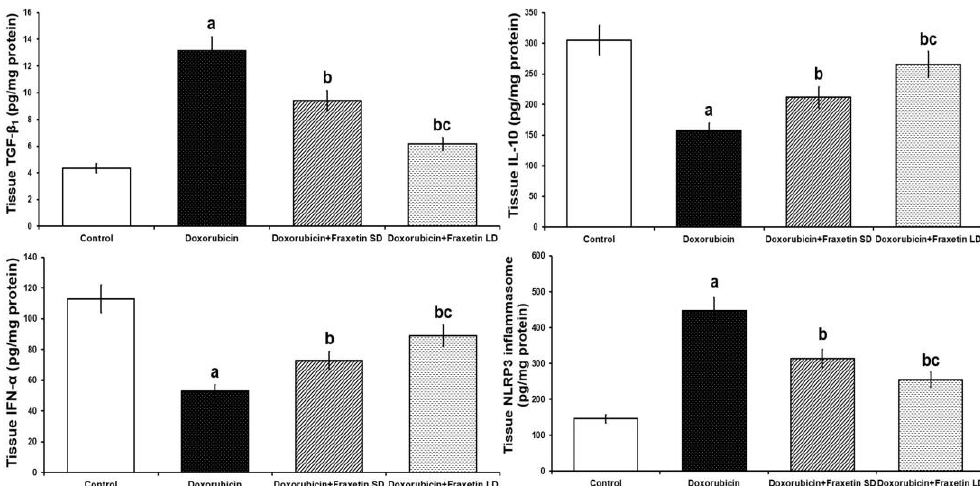
Figure 2. Effect of different doses of fraxetin on cardiac tissue TGF-β1, IL-10, IFN-α, and NLRP3 inflammasome in doxorubicin-treated rats (Mean ± SD). a Significant relative to the control group ( p -value less than 0.05); b Significant relative to doxorubicin group ( p -value less than 0.05); c Significant relative to doxorubicin + fraxetin small dose group ( p -value less than 0.05).